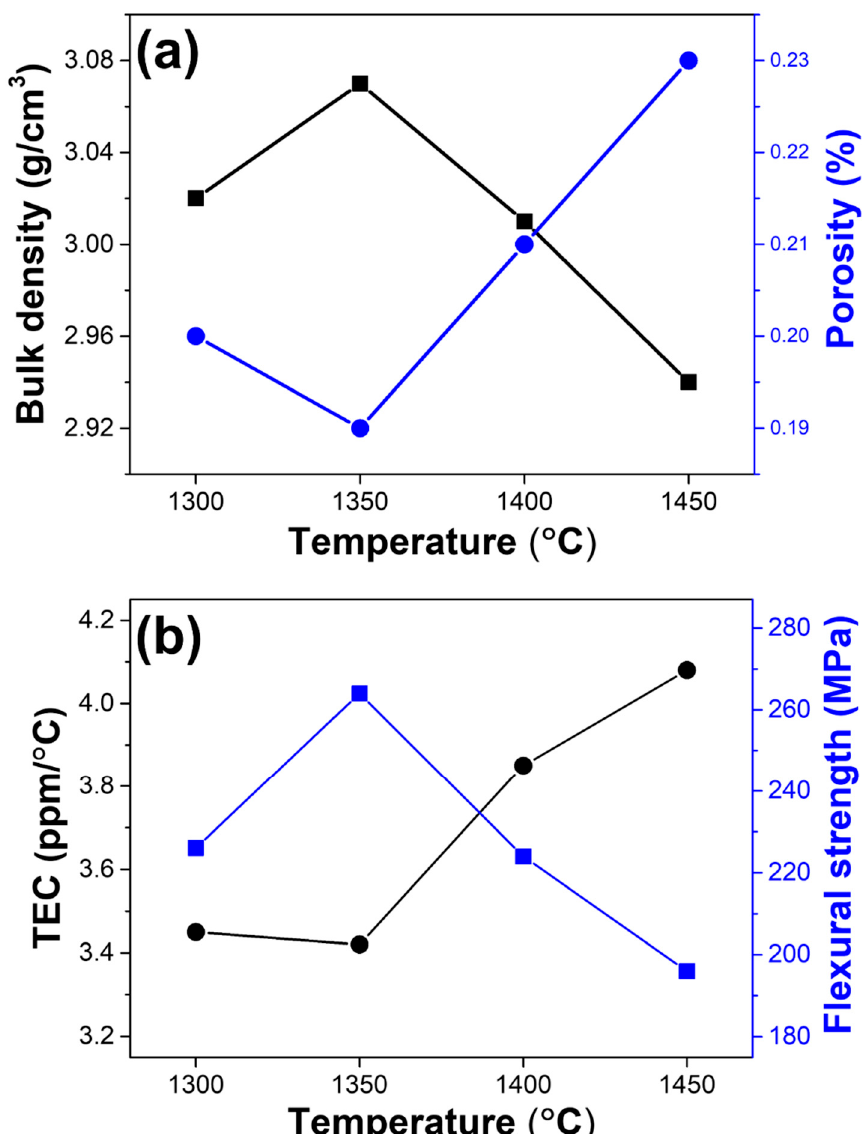
Figure 6. Variation in the physical and mechanical properties of the mullite–cordierite composites at different sintering temperatures: ( a ) bulk density and porosity and ( b ) TEC and flexural strength.